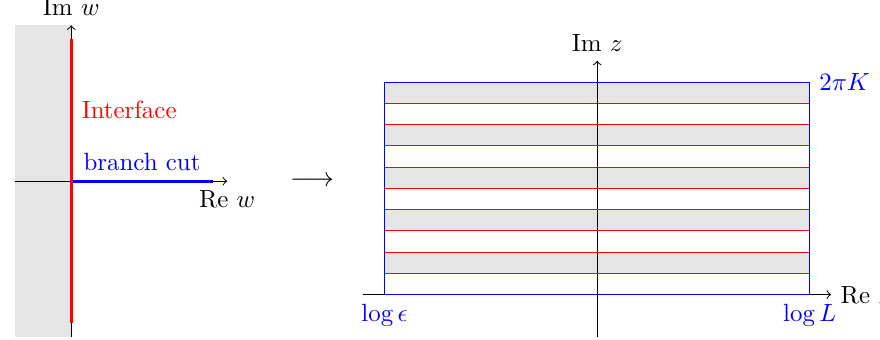
Figure 1 . Sketch of the K -sheet Riemann surface R K that one needs for the replica trick. After imposing a IR citoff (cid:15) , an UV cutoff L , and suitable variable transformation, R the